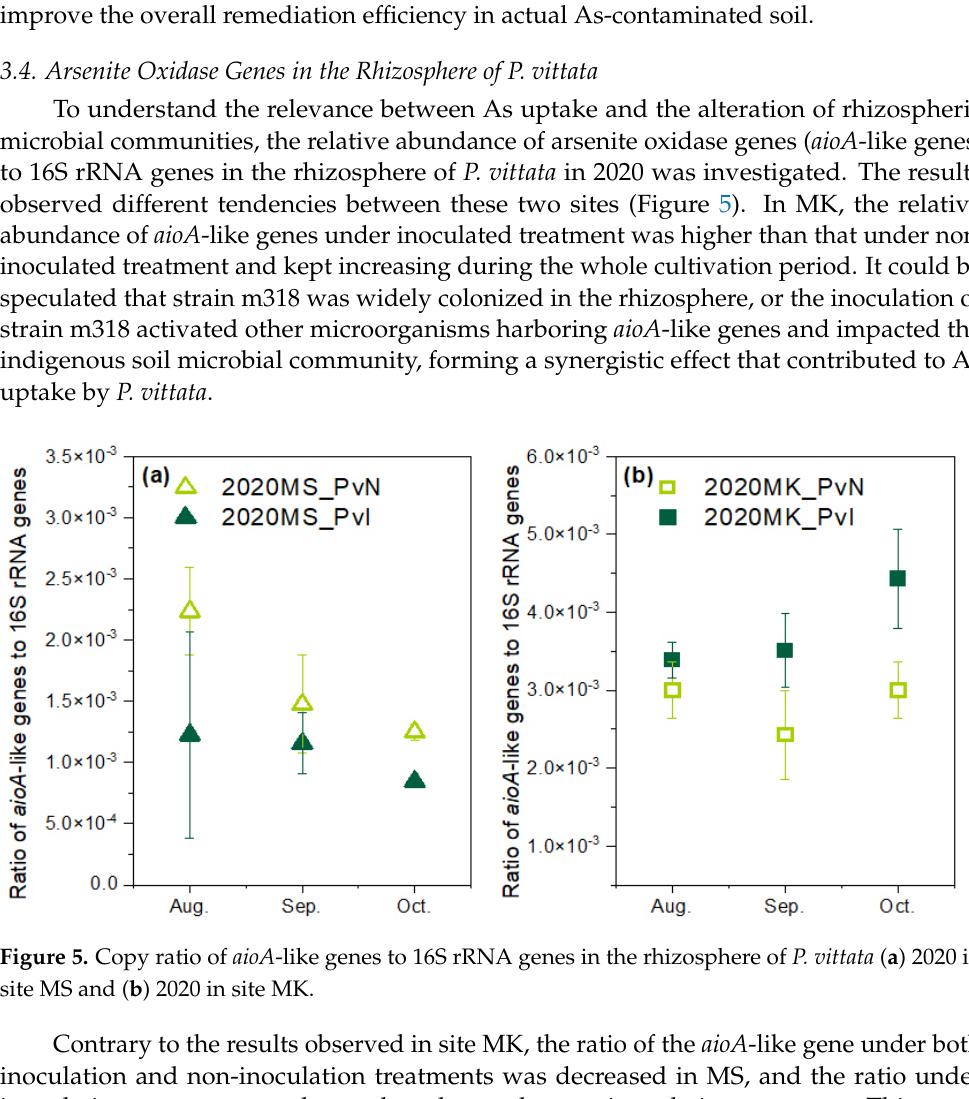
Figure 4. Arsenic accumulation in a P. vittata plant in ( a ) site MS in 2019 ( b ) site MK in 2019 ( c ) site MS in 2020, and ( d ) site MK in 2020. Data with different letters indicated significant differences ( p < 0.05) according to ANOVA by Tukey HSD test.